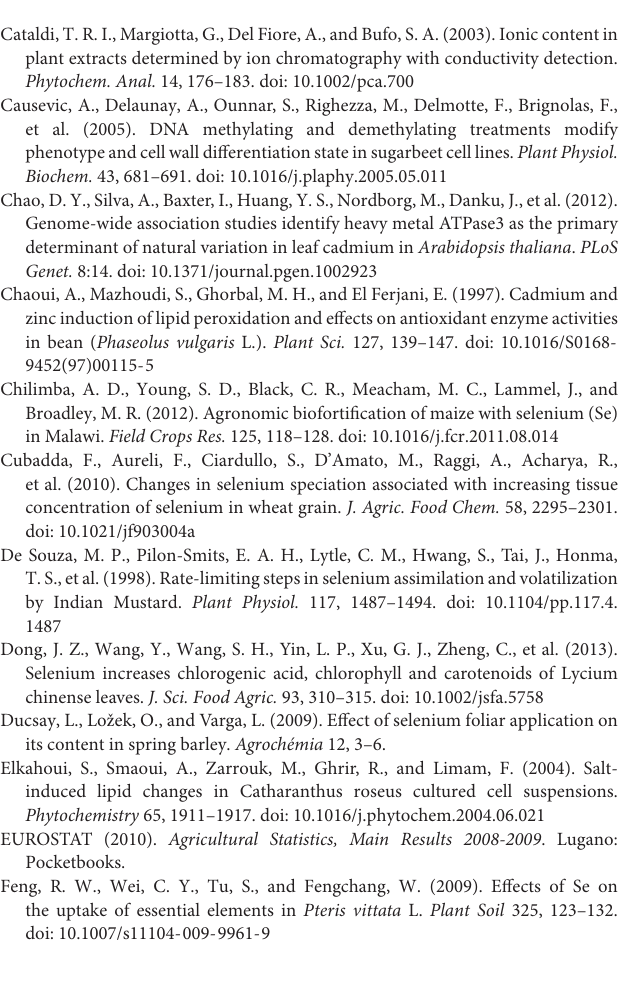
TABLE S1 | Instrumental settings of the ICP-MS and HPLC. TABLE S2 | MSAP primer combination. TABLE S3 | Moisture of aerial parts and roots. Length of aerial parts. TABLE S4 | Principal component analysis,